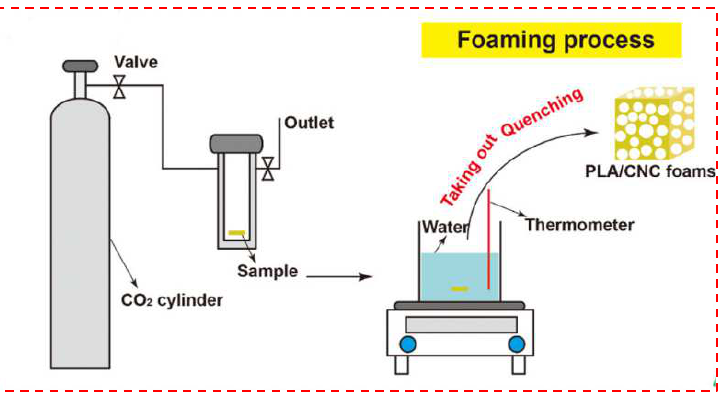
Figure 3. Principle of the temperature-induced batch foaming process (reproduced with permission from Reference [69], Copyright 2021 American Chemical Society).